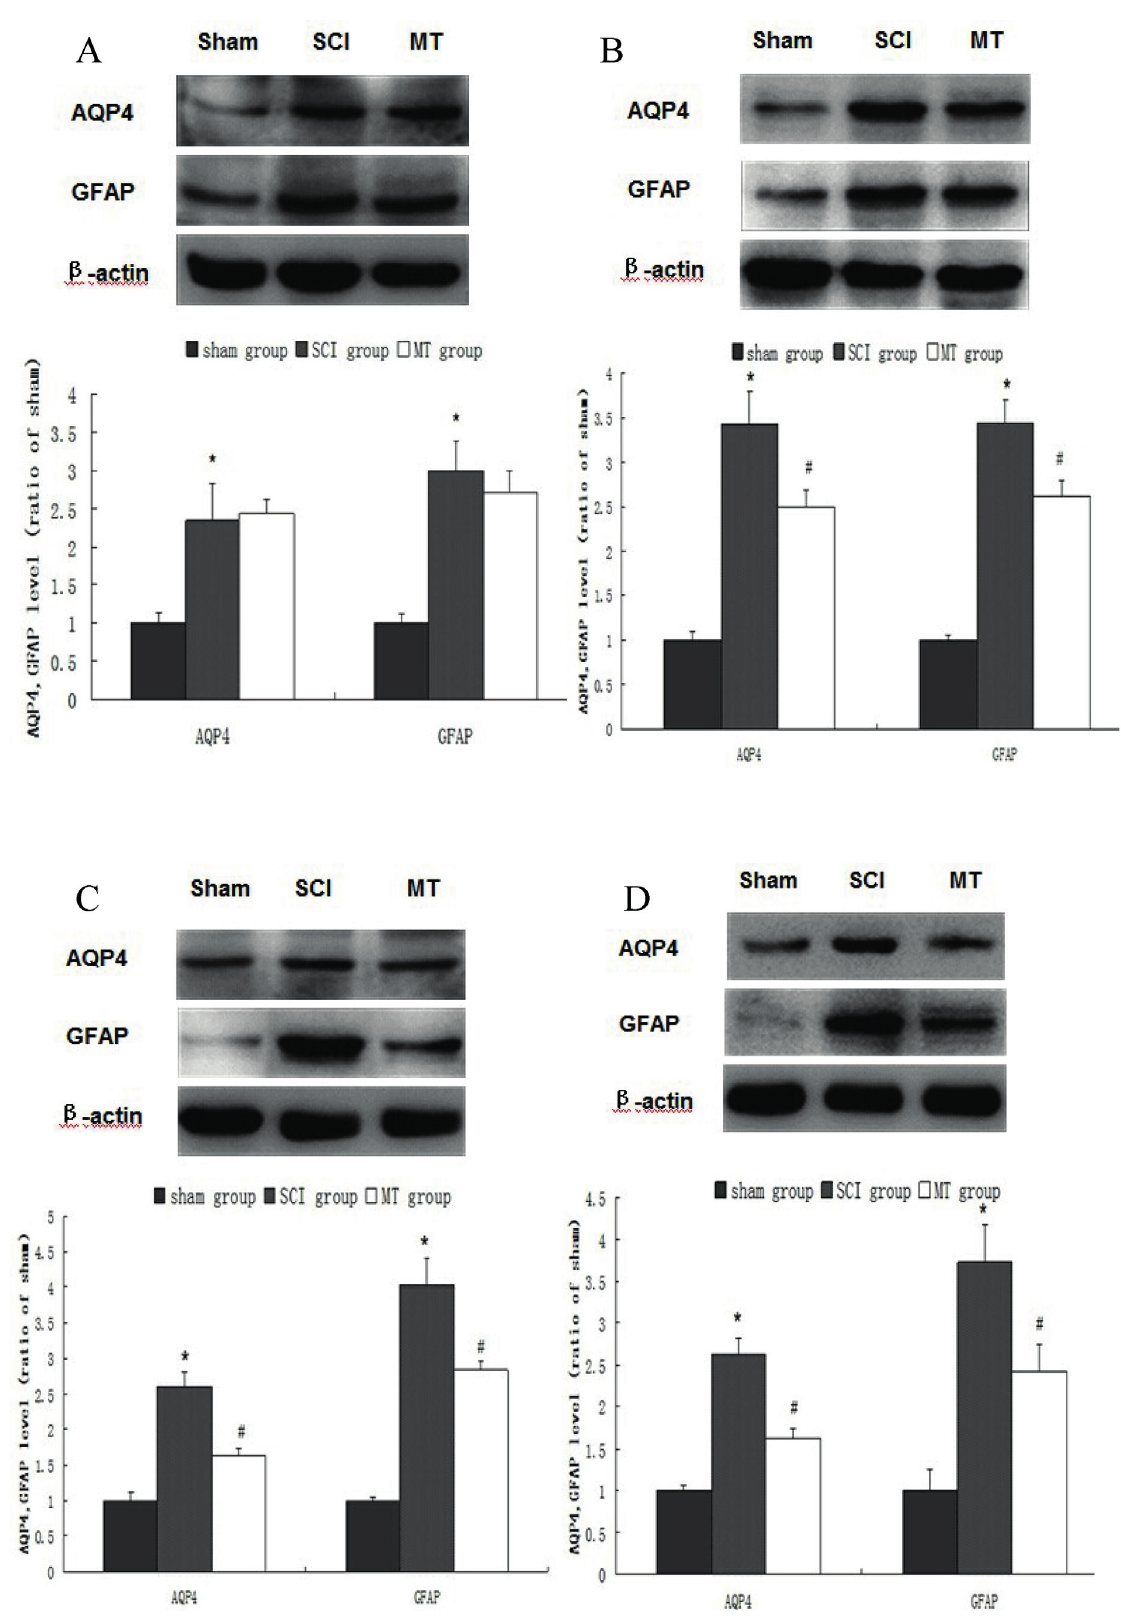
Fig. 3. Western blot analysis for AQP4 and GFAP protein levels at 12 (A), 24 (B), 48 (C) and 72 h (D) after injury. AQP4 was detected at 34 kDa, GFAP was detected at 50 kDa and the loading control β-actin at 43 kDa. The graph showed significantly up- regulation of AQP4 and GFAP expression level in SCI group at 12, 24, 48 and 72 h after SCI. Treatment of melatonin (100 mg/ kg) could markedly decrease AQP4 and GFAP levels in the spinal cord at 24, 48 and 72 h after injury. There were no significant differences in AQP4 and GFAP protein levels between SCI group and melatonin group at 12 h post-injury. Bars represent mean ± SD (n=5, * P <0.05 between Sham group and SCI group, # P <0.05 between SCI group and melatonin